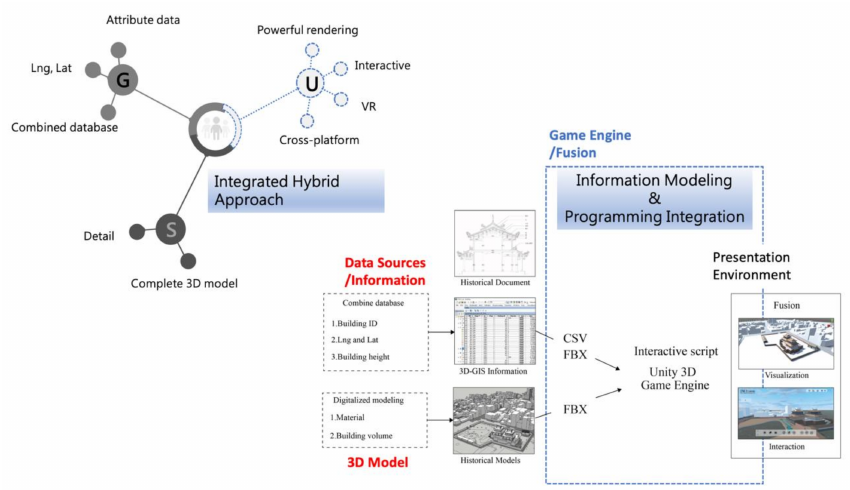
Figure 10. Platform